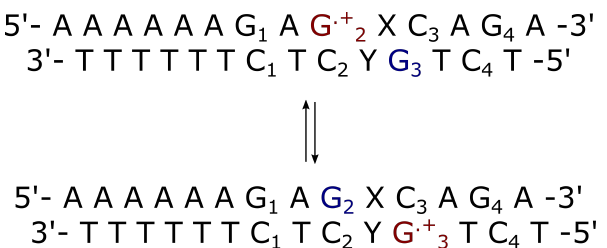
Figure 4. Schematic representation of interstrand charge transfer in double strands where the bridge is X = { A,T } and Y is the complementary strand of X. The electron donor is G 3 (in blue) and the acceptor is G . + (in red). These two Guanine bases belong to different 2